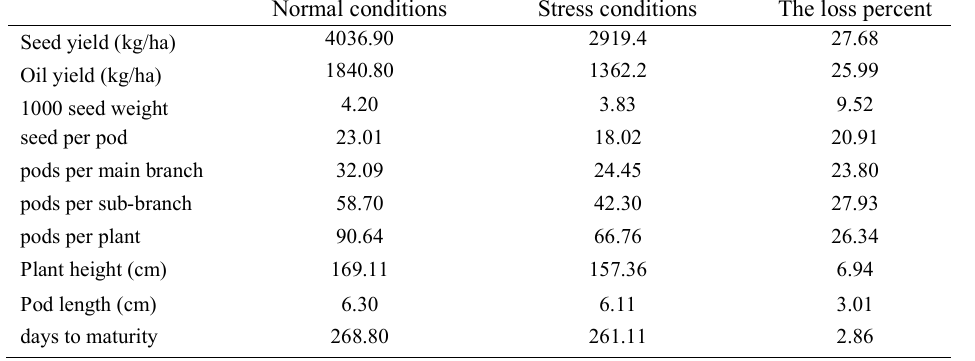
Table 2. Average of studied traits in normal and drought stress conditions and the loss percent of traits in rapeseed (B. napus) Normal